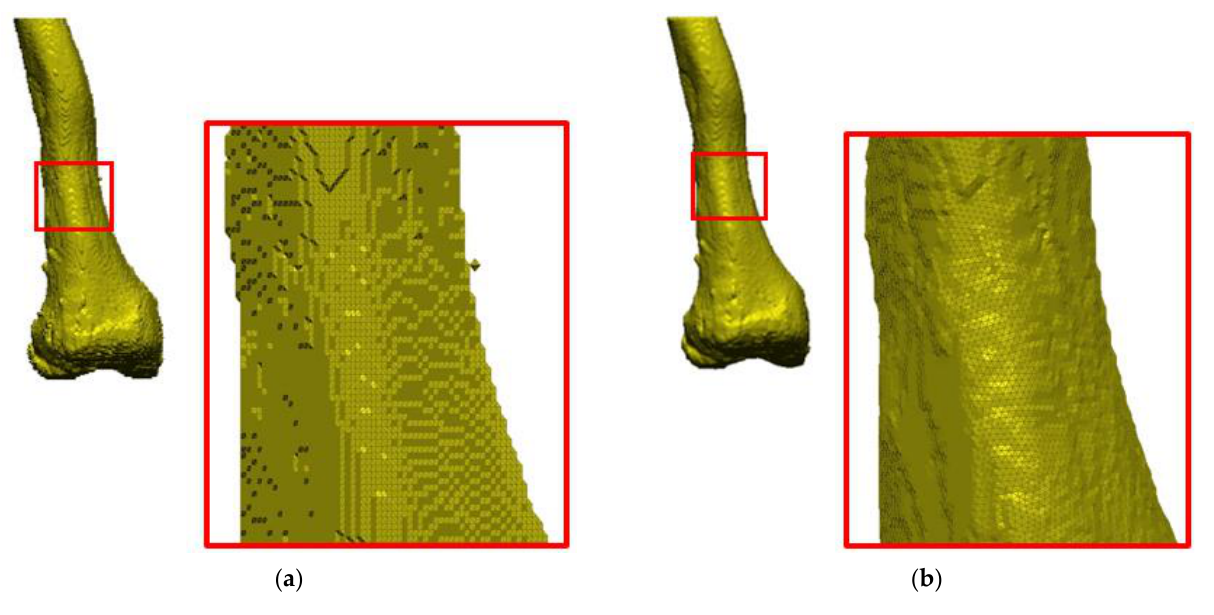
Figure 8. Process of editing the faceted surface: ( a ) Prior to editing and ( b ) following editing.